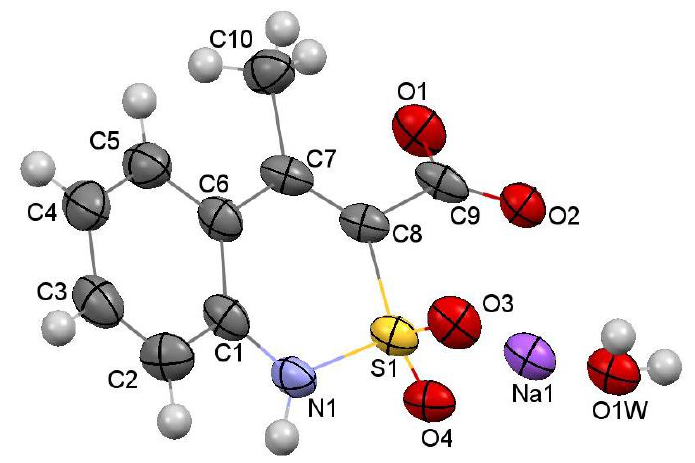
Figure 3. The standard representation of different atoms in different colors. The molecular structure of sodium salt monohydrate 3 with atoms represented by thermal vibration ellipsoids of 50% probability.